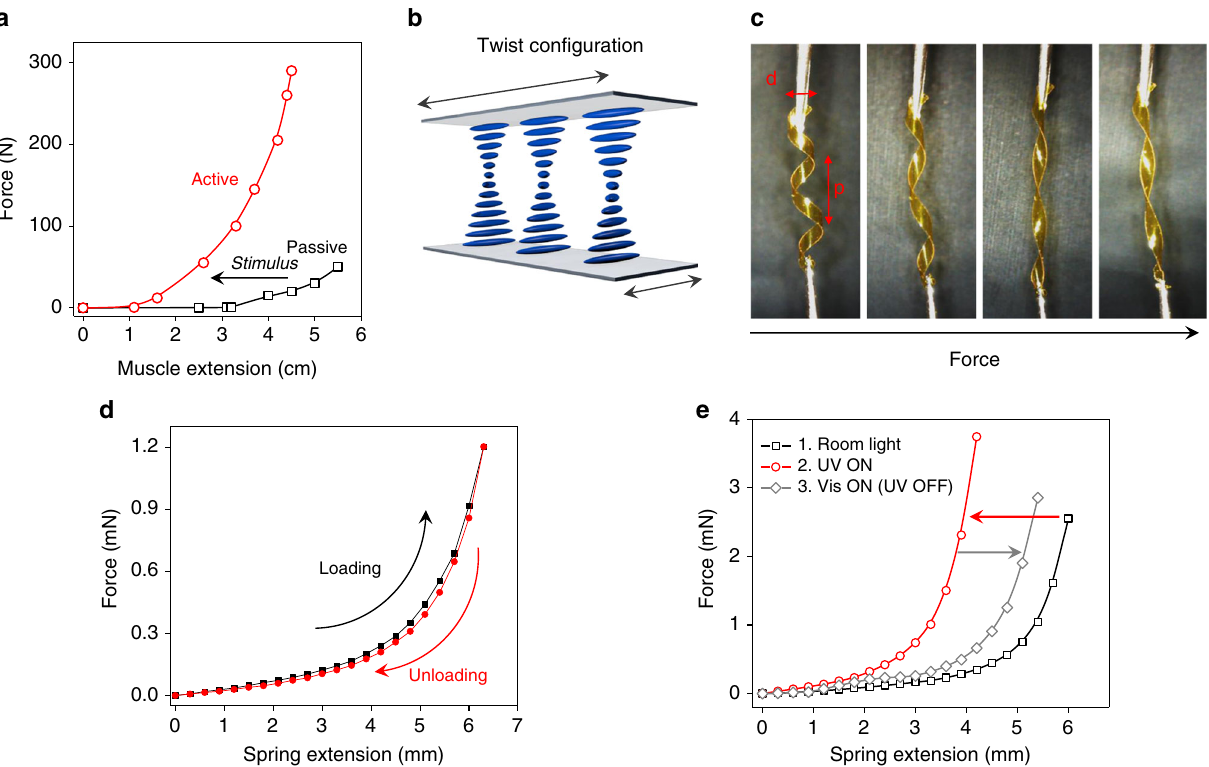
Fig. 5 Muscle-like mechanical behavior from springs of light-stiffening materials. a Nonlinear extension of passive and active muscle fi bers in response to a pulling force. Reproduced from R. Shadmehr & M. A. Arbib, Biol. Cybern . 66, 463 – 477 (1992). b Twist con fi guration of liquid crystals in a glass cell. c Response of a liquid crystal polymer spring to increasing pulling forces. d Loading (increasing pulling force) and unloading (decreasing pulling force) of the springs, displaying nonlinear and reversible strain stiffening, in which hysteresis is negligible. e Muscle-like behavior of ground state (black) and light- activated (red) polymer springs as shown from force-extension curves (here the molar ratio between the free liquid crystal and the azobenzene is R =